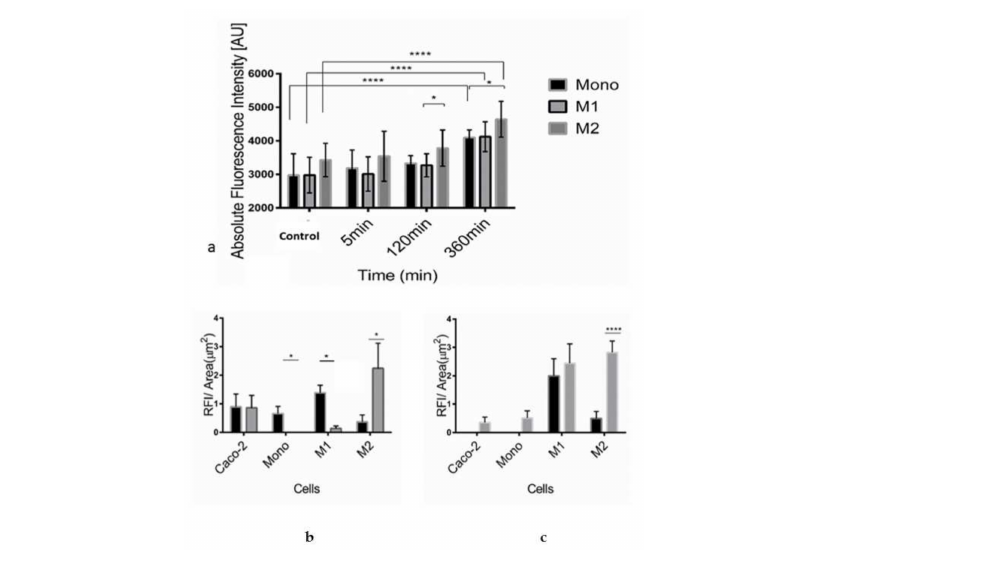
Figure 1. Acid SMase secretion was analyzed from the supernatants of human monocytes, M1- and M2-macrophages in the absence of TNF- α treatment (control) and after 5 min, 120 min, or 360 min treatment with 50 ng/mL TNF- α ( a ). Acid sphingomyelinase activity was studied using Amplex Red sphingomyelinase assay. In the assay, the formed ceramide is traced from the formed fluorescent by-product, which equals the formed ceramide’s molarity. Bars represent mean ± SEM of triplicate repeats ( n =3). A non-parametric t -test determined significance. Liposomal internalization efficacy of monocytes, M1- and M2-macrophages, and Caco-2 cells were analyzed, measuring RNASelect fluorescence from the cells. Cells were incubated with SM-liposomes loaded with RNASelect (grey columns) or as control free RNASelect (black columns) in the absence ( b ) or presence (3 h) of 50 ng/mL TNF- α ( c ) for 30 min following washes with PBS for three times. Bars represent mean ± SEM of triplicate repeats. A non-parametric t -test determined significance. * p < 0.05, **** p <